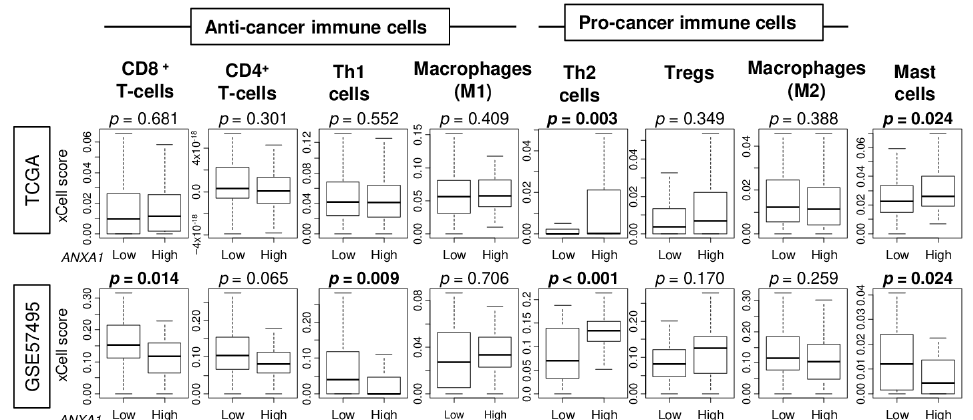
Figure 4. Association of the ANXA1 expression and infiltrating immune cells in pancreatic cancer in the TCGA and GSE57495 cohorts. Boxplots of the infiltrating fraction of CD8 + T cells, CD4 + T cells, T-helper types 1 and 2 (Th1 and Th2), regulatory T cells (Tregs), M1 and M2 macrophages, and Mast cells by ANXA1 low and ANXA1 high groups. Median cut-off within each cohort was used to divide into ANXA1 low and ANXA1 high groups ( n = 88, respectively, in the TCGA and n = 31 and 32, respectively, in the GSE57495 cohort). p -values were calculated by the Mann–Whitney U test.